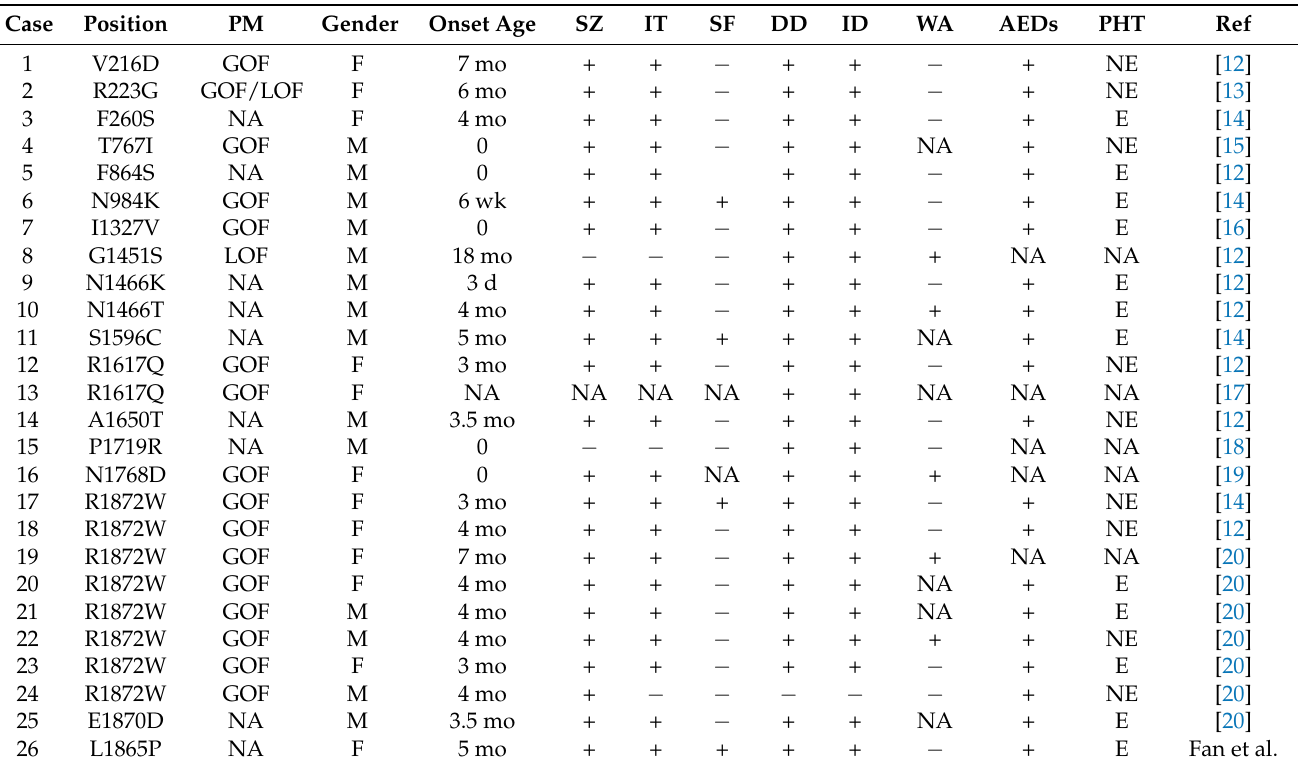
Table 1. Summary of 26 patients carrying an SCN8A